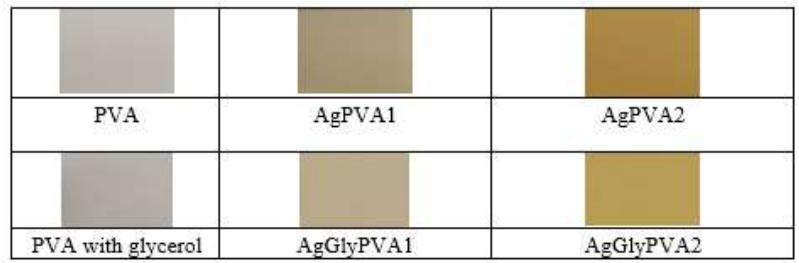
Figure 2. PVA, AgPVA, and AgGlyPVA films after irradiation with 5 Gy dose.